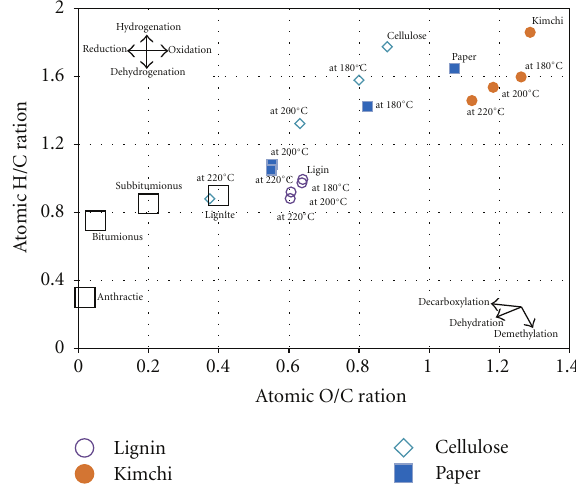
Figure 5: Coalification band of the paper and the kimchi at di ff erent hydrothermal reaction temperatures in comparison with cellulose, lignin and